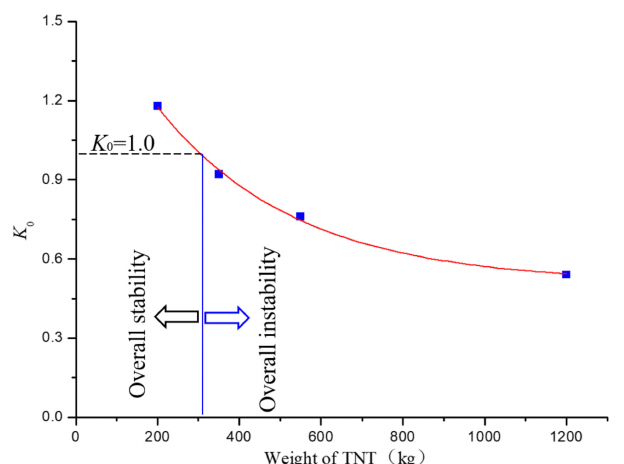
Figure 18. The antisliding stability safety factor K 0 for the arch dam for different masses of